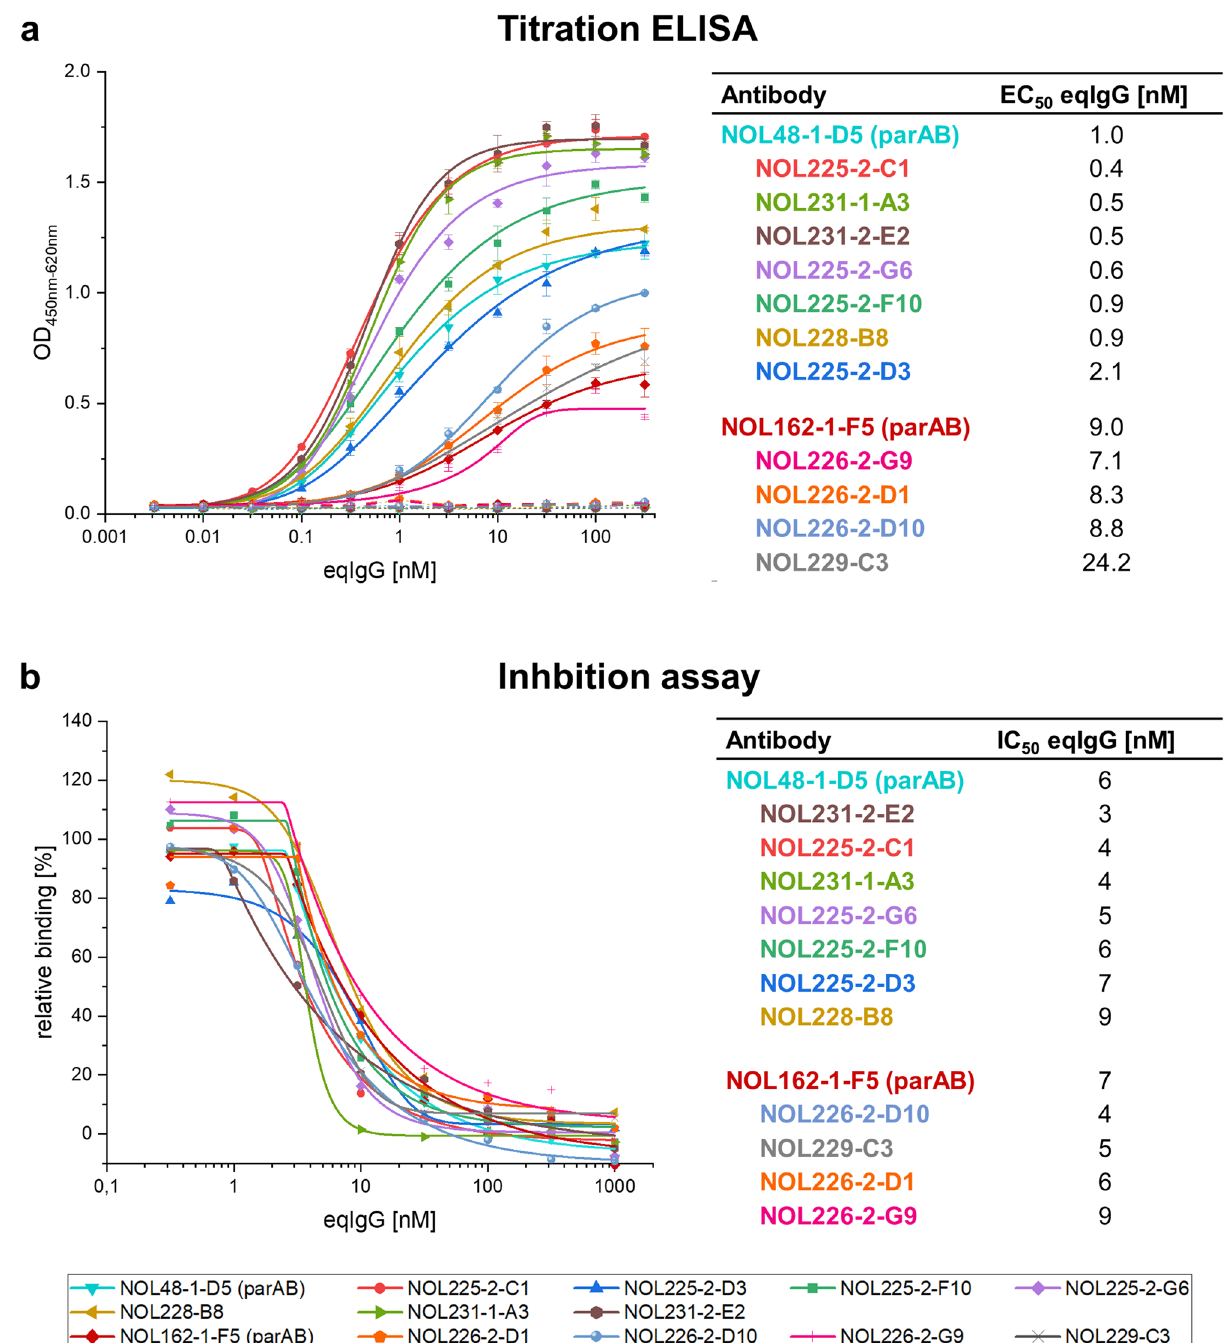
Figure 3. Titration ELISA and cellular inhibition assay for affinity-matured antibodies. ( a ) Titration ELISA of affinity-matured antibodies derived from the parental antibodies NOL48-1-D5 and NOL162-1-F5. Antibodies were titrated on immobilized antigen in eqIgG6 format using 316 nM–0.0032 nM antibody. As negative control, antibodies were titrated on 1% BSA (marked with dashed lines). EC 50 values were determined with OriginPro using the Logistic5 Fit. Measurements were performed in triplicates (n = 3). ( b ) Titration inhibition assay with affinity-matured antibodies derived from the parental antibodies NOL48-1-D5 and NOL162-1-F5. Antibodies were titrated in eqIgG6 format using 1000 nM–0.32 nM antibody and 5 nM antigen (related to dimer) (molar ratio 200:1–0.064:1). IC 50 values were determined with OriginPro using the Logistic5 Fit. Measurements were performed in single measurements (n = 1). parAB parental